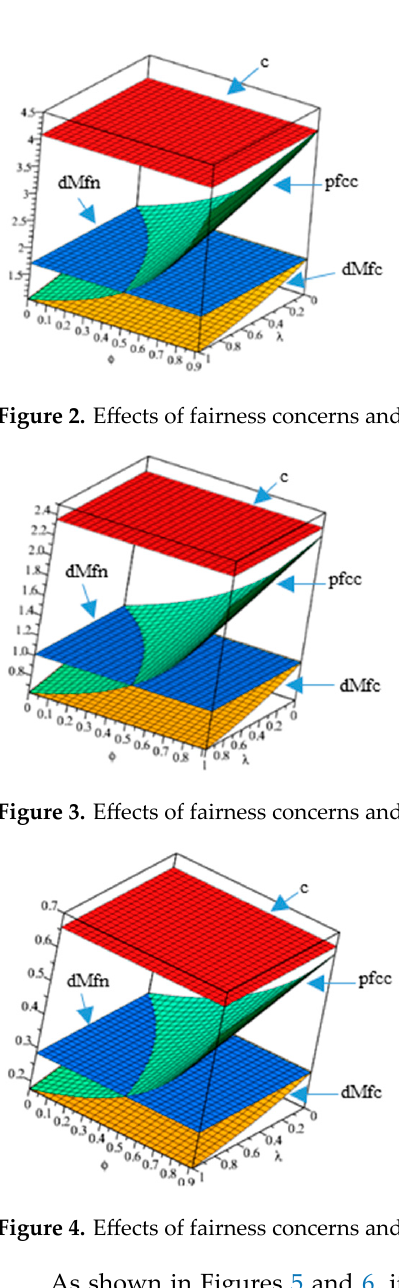
Figure 1. Effects of fairness concerns and profit-sharing on wholesale prices.